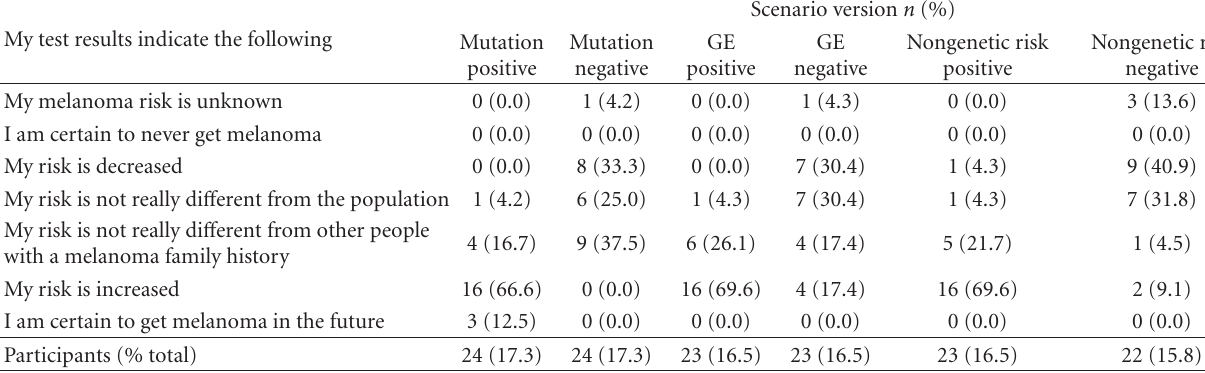
Table 1: Scenario interpretation response frequencies ( N =